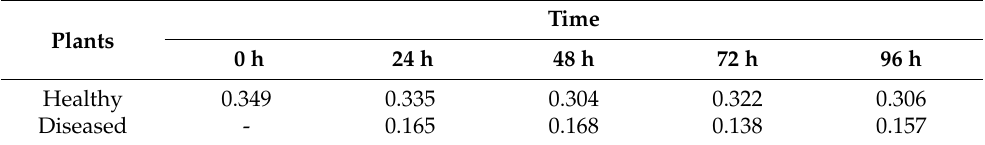
Figure 4. The distribution PZ of the ratio F v / F m ( F m maximum fluorescence and F v = F m − F 0 , F 0 minimum fluorescence) is the black curve with circle points, and the normal approximation is the red curve with crossed points. The parameters β , ρ , and δ y of the distribution PZ are associated with the mean value of these parameters over the six days of the acquisition of chlorophyll fluorescence images for ( a ) Healthy: β = 0.192, ρ = 5.377 and δ y = 0.461 and ( b ) Diseased: β = 0.358, ρ = 3.359 and δ y = 0.976 plants of the fungal pathogen data set. Table 9. Fourth-order fractional moment of PZ distribution of the ratio for the Healthy and Diseased plants of the fungal pathogen data set. 0 h, ..., 96 h are the five times of the acquisition of chlorophyll fluorescence